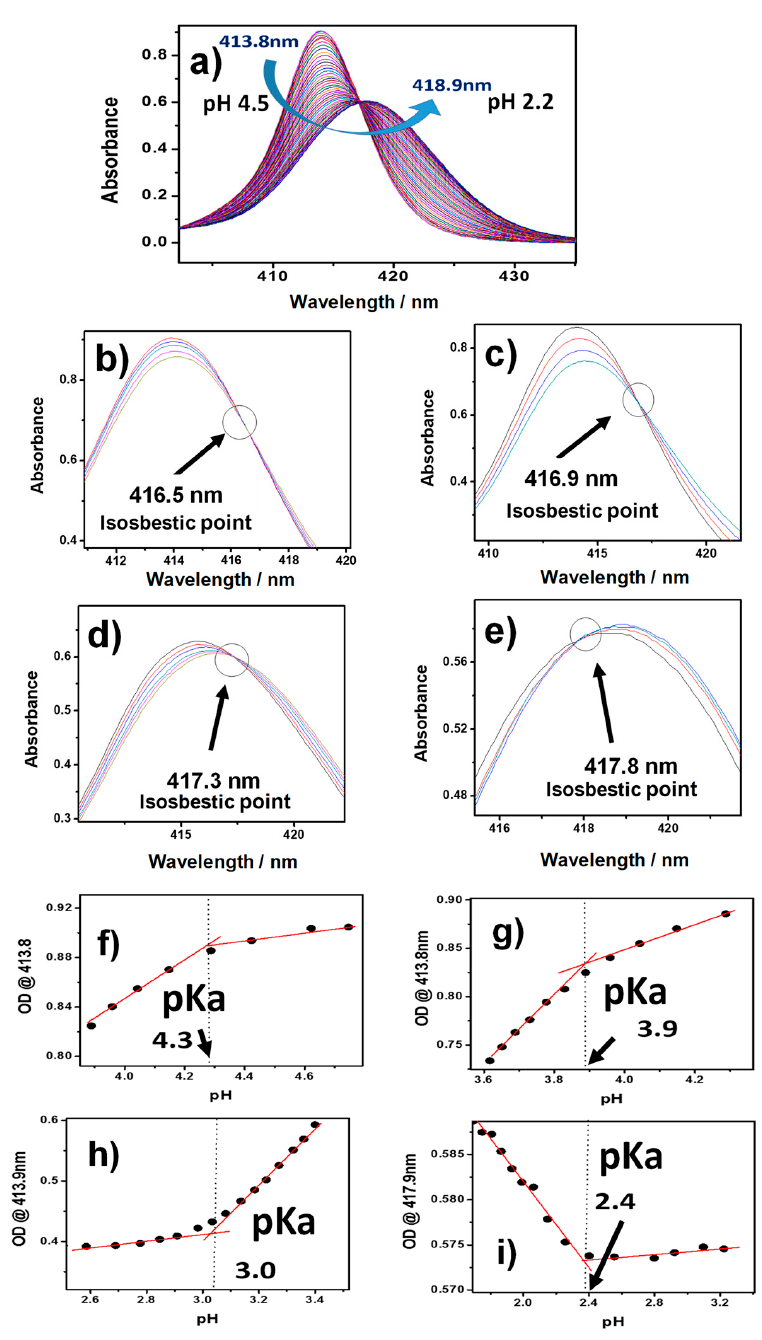
Figure 2. ( a ) Opposite red shifting of the λ max (Soret band) of SnTPyP (1.4 × 10 − 6 M in CH 3 CN/H 2 O (8/2, v / v )) in the pH region 4.5 to 2.2, ( b – e ) isosbestic points (circles) observed in the pH region 4.5–2.2, ( f – i ) p K a values estimated from the inflection points in the plots between pH vs. OD in the pH region